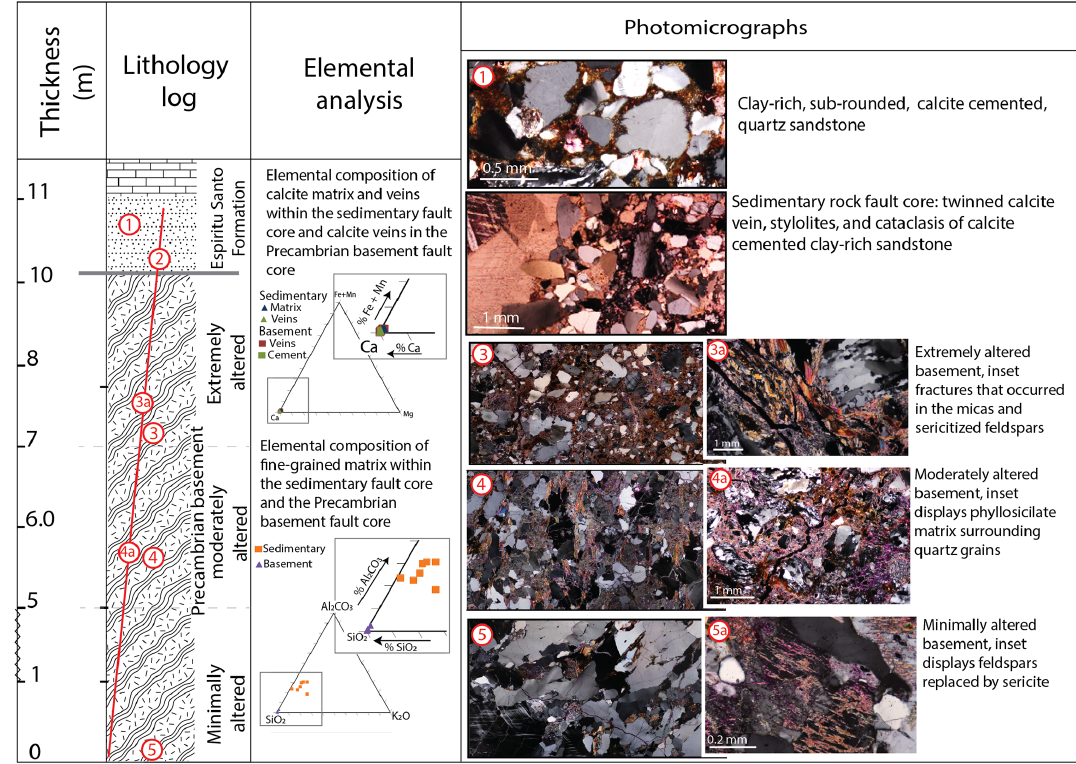
Figure 8. Petrographic and elemental analysis summary of nonconformity units at the Gallinas Canyon site. Thickness is measured in meters from base of outcrop section; the red line represents a fault. Elemental analysis shows a similar calcite composition of the veins within the sedimentary sequence and the Precambrian basement faults. (a, b) The Espiritu Santo sandstones are clay-rich calcite-cemented quartz sandstones; in the fault core, (b) the sandstones are cut by twinned calcite veins and stylolitic textures and contact cataclastic. (c) Adjacent to the nonconformity the granitic basement contain fractures in the micas and sericitized feldspars. (d, e) Basement alteration decreases away from the nonconformity, with a phyllosilicate matrix surrounding quartz grains and sericitization of feldspars occurring 10m from the